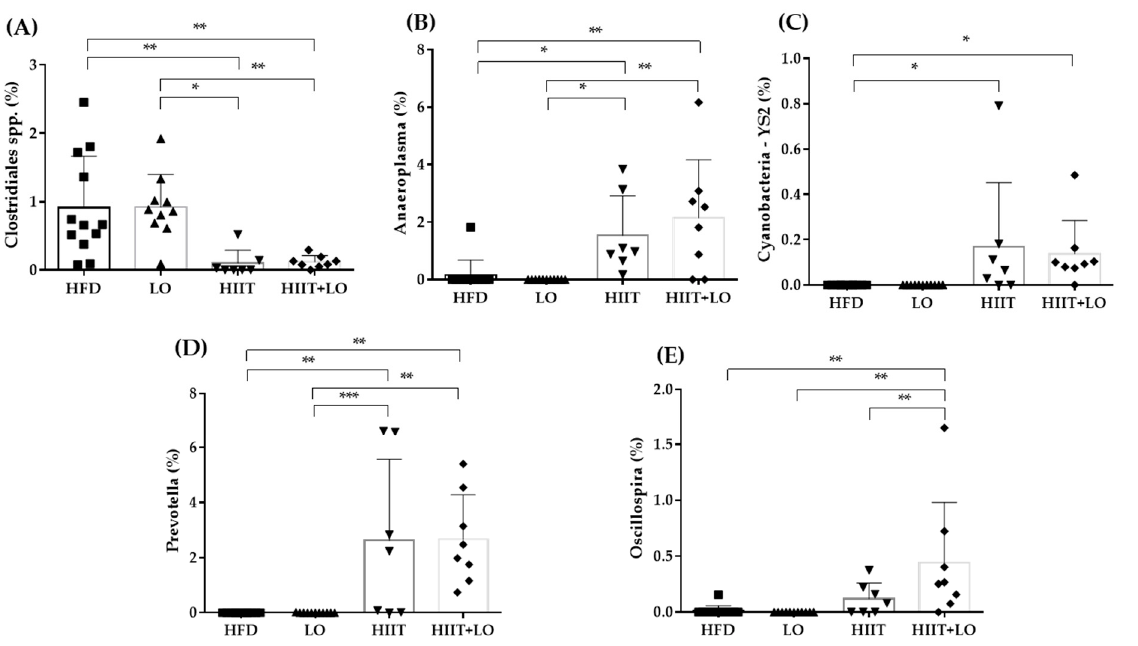
Figure 8. Relative abundance (%) of specific bacterial types in the mucosa-associated microbiota of the four groups: Clostridiales spp ( A ), Anaeroplasma ( B ), Cyanobacteria YS2 ( C ), Prevotella ( D ), Oscillospira . ( E ). HFD ( n = 12), LO ( n = 11), HIIT ( n = 7), and HIIT+LO ( n = 8) at the end of phase 2 (training and/or LO supplementation for 12 weeks). * p < 0.05, ** p < 0.01, *** p < 0.001.